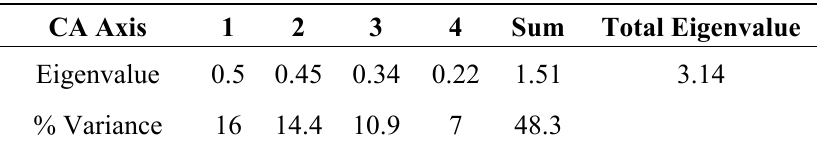
Table 1. Correspondence Analysis (CA) results for the combined datasets of Cape Bounty (CB) and Sanagak Lake